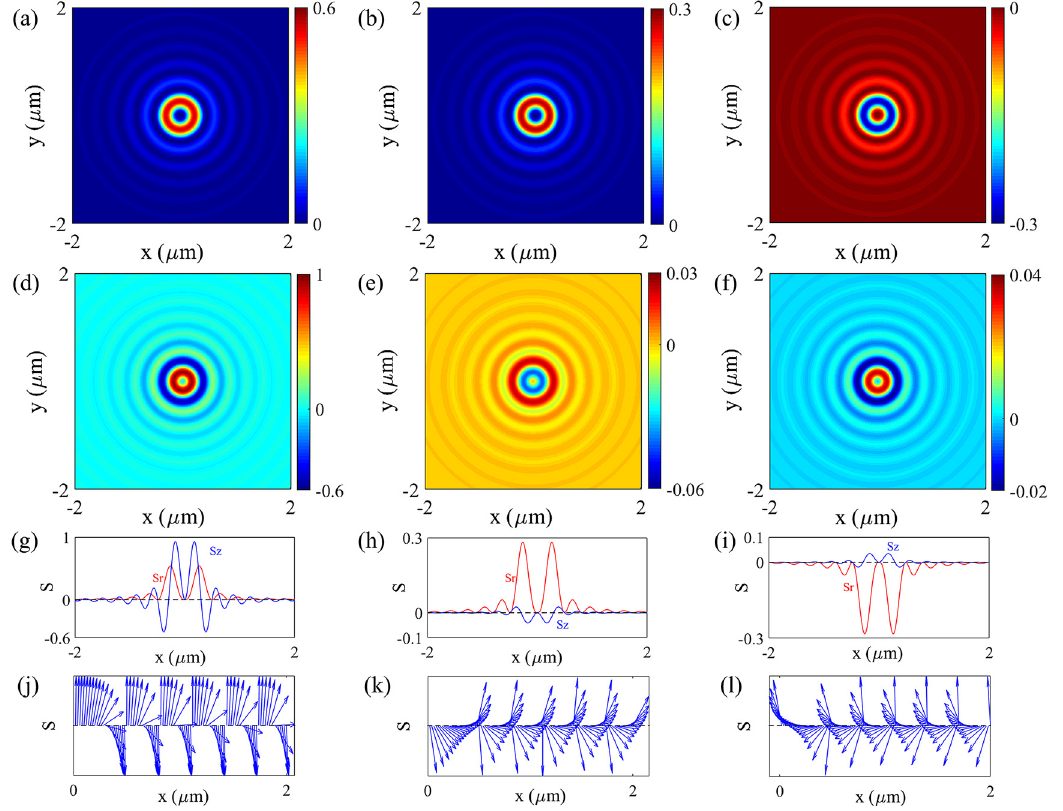
Figure1: Thespinpropertiesof p -polarizedBessel-typesurfacemodewithtopologicalcharge l = + 2.Theradialspinangularmomentum(SAM) (a)andout-of-planeSAM(d)componentsofsurfacemodeintheupperhalf-space(at z =10nm)astherelativepermittivityandpermeabilityare 1; the corresponding 1Dcontourandnormalizedspintexturecan befound in(g)and(j), respectively. The radial SAM (b)andout-of-planeSAM (e)componentsof surface mode inthe lower half-space(at z = − 10 nm)as the relative permittivityandpermeability are respectively − 11.8and 1;thecorresponding1Dcontourandnormalizedspintexturecanbefoundin(h)and(k),respectively.TheradialSAM(c)andout-of-planeSAM (f) components of surface mode in the lower half-space (at z = − 10 nm) as the relative permittivity and permeability are respectively 11.8 and − 1.5; the corresponding 1D contour and normalized spin texture can be found in (i) and (l), respectively. The sign of out-of-plane spin orientation is determined by the permittivity, while the direction of in-plane spin orientation is related to the permeability. The wavelength is 633 nm and all quantities are normalized to the maximal absolute value of total SAM in the upper